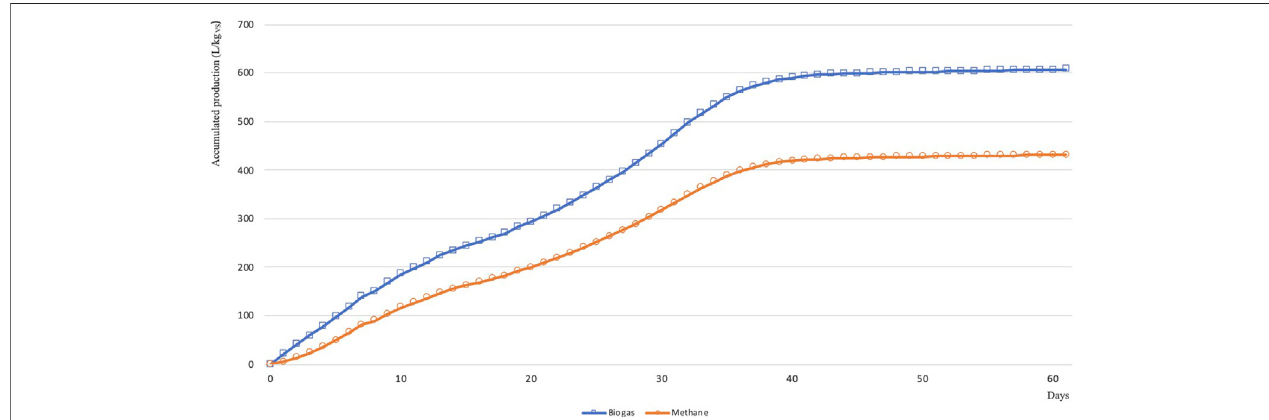
FIGURE 7 | Yield of biogas and methane